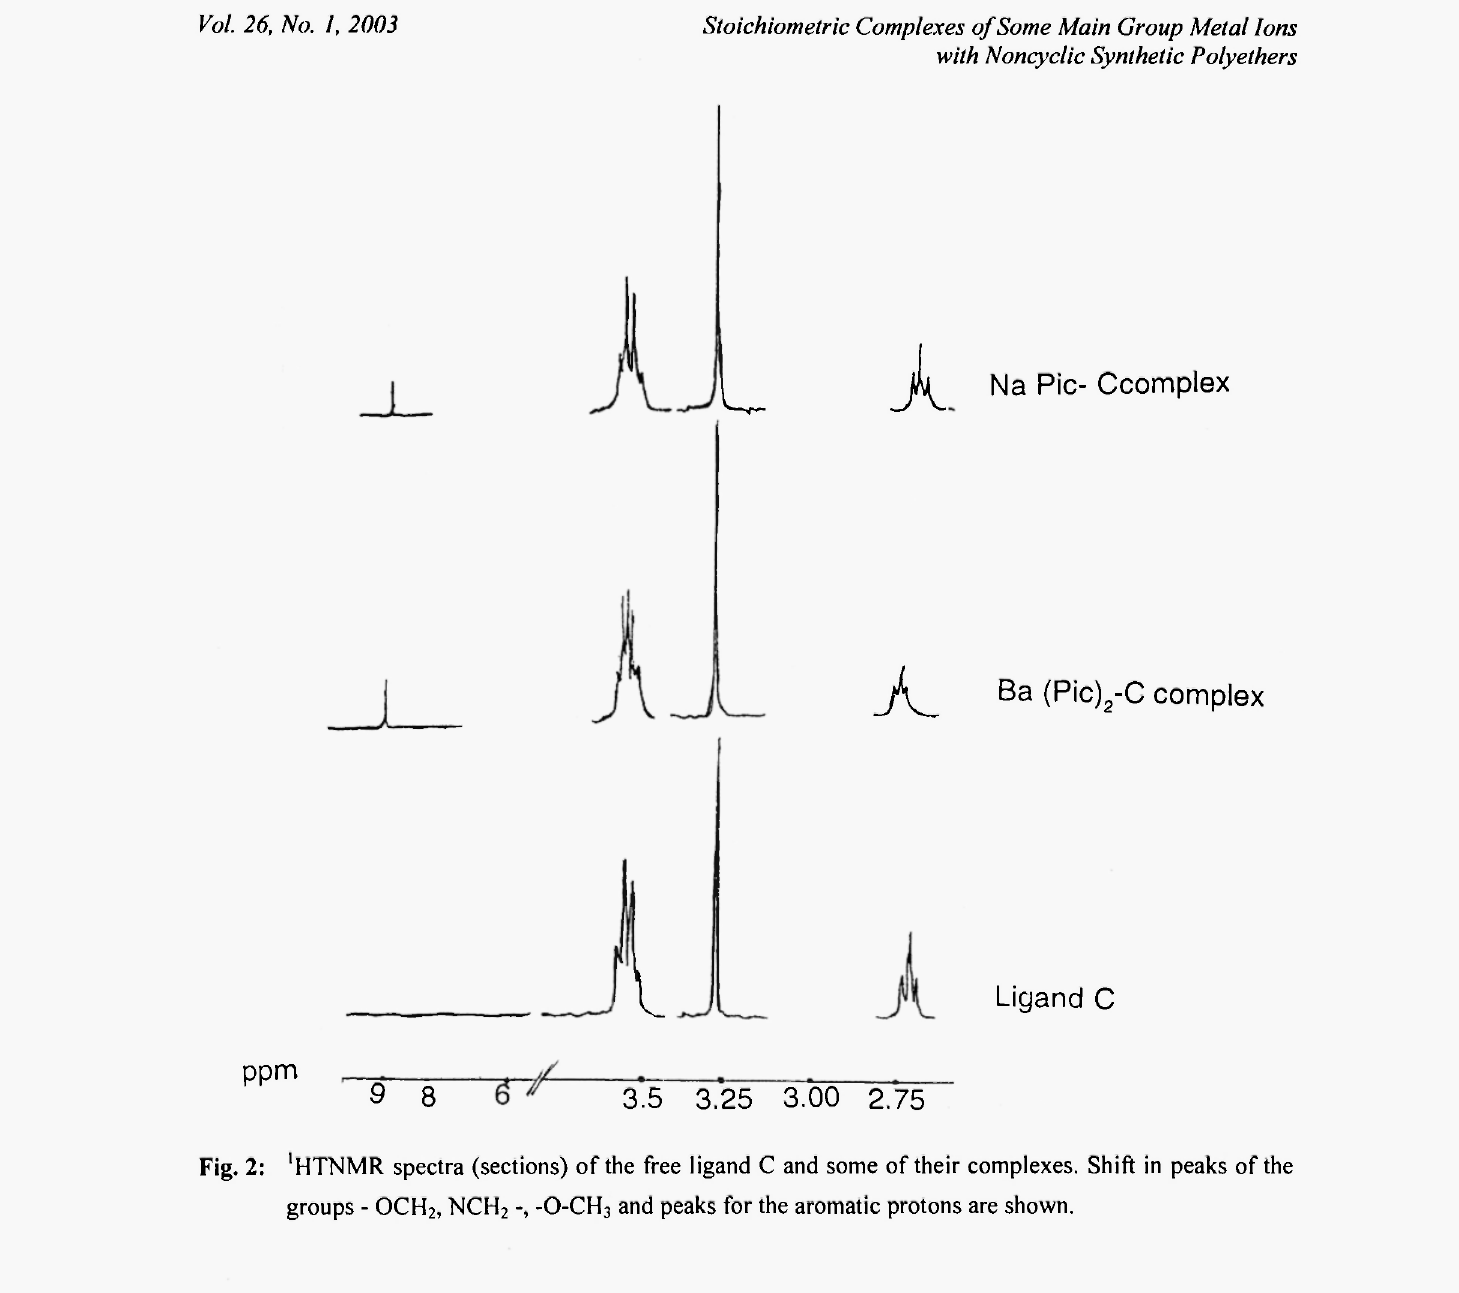
barium and strontium. Divalent ions possess smaller size and much higher charge density than monovalent cations and this promises stronger interaction with donor oxygen atoms of ligand molecules. X-ray studies of crystalline complexes /4/ formed by podands indicate that, as the number of donor oxygen atoms increases, ligand wraps round the metal ion in a helical way. The whole ligand skeleton is held in the podate conformation only by the cation - donor atom interactions 151. In the case of ligand C the three - OCH 3 terminal groups may have participated in co-ordination of the metal ions (Na + , Ba 2+ and Sr 2+ ) located at the centre of the pseudocavity 121. All the complexes of ligand C contain water in stoichiometric proportions, as revealed by the appearance of more or less sharp -OH bonds in the IR spectra. The question whether the H 2 0 molecules are in co-ordinational contact with the complexed cation or exist as free water of crystallization in the crystal lattice 161 will only be conclusively settled by X-ray structure